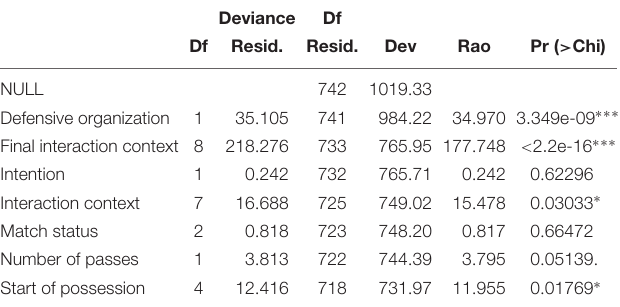
TABLE 4 | Analysis of deviance